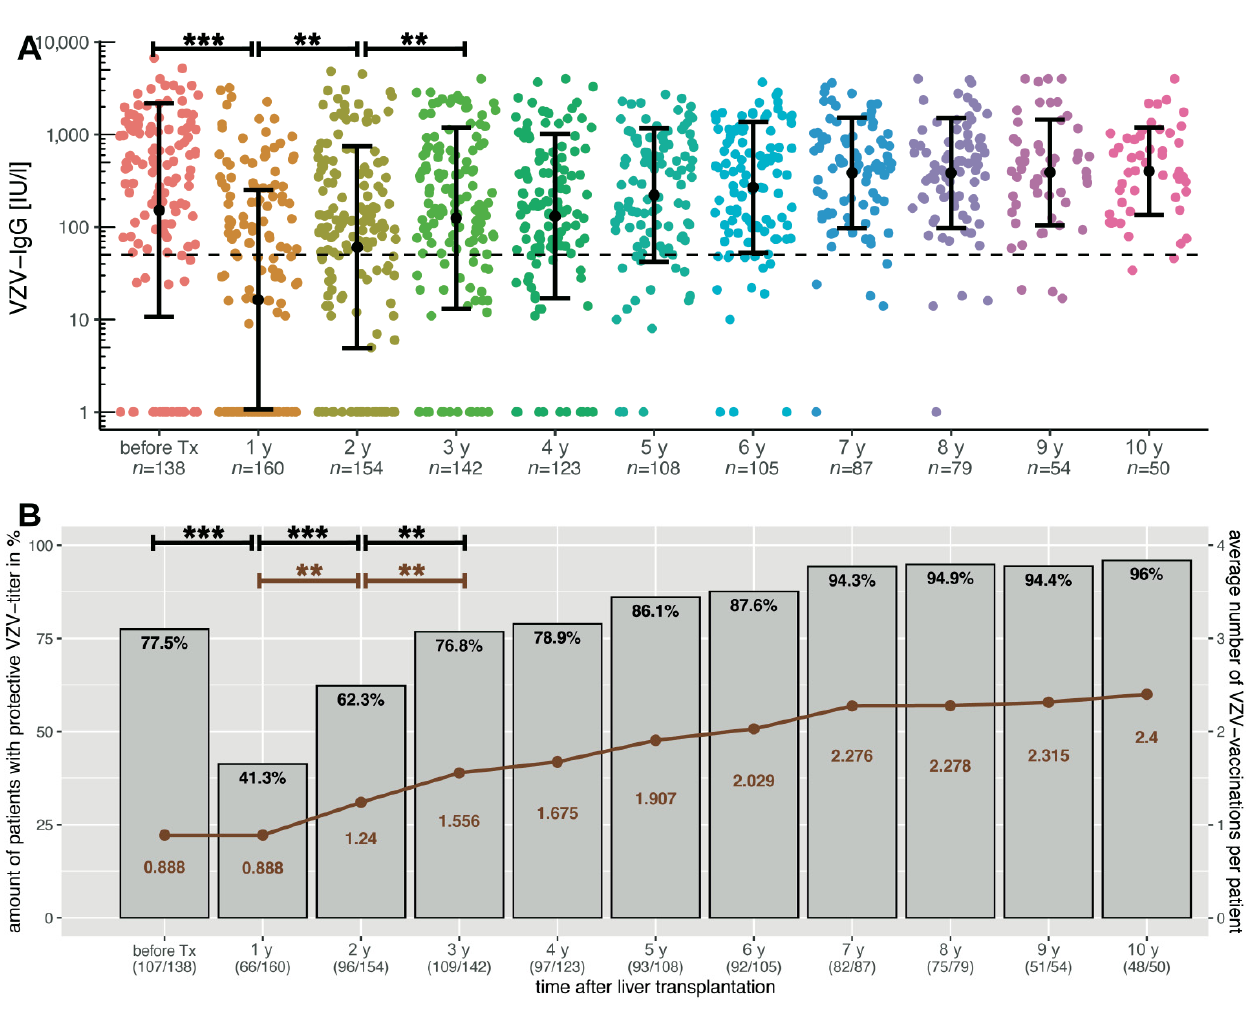
Figure 3. ( A ) VZV-specific antibody course in paediatric liver transplant recipients over ten years after transplantation. The y -axis is scaled logarithmically. Data is shown as mean ± standard deviation. The dashed line marks the threshold for serological protection. The titre dropped significantly up to the first annual check but increased over the next few years with the possibility of vaccination, even if this increase was only significant at the second and third annual check. This also affected the numbers of patients with protective VZV titres, as shown in the bar plots in ( B ). The brown graph shows the average number of VZV vaccinations per patient. This was stable from the seventh annual check-up on, when around 95% of all patients were serologically protected, which required an average of 2.3 vaccinations per patient. Significant data is marked as follows: ** <0.01, *** <0.001.